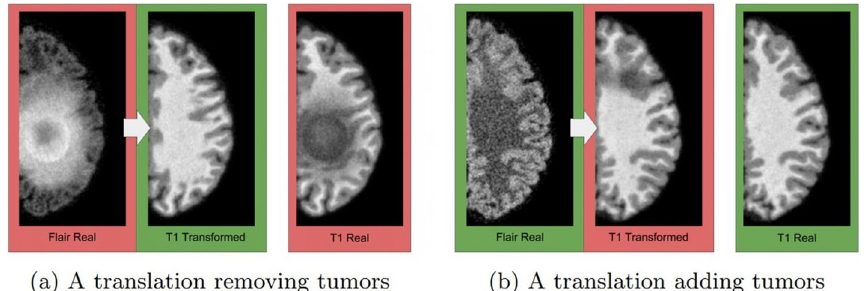
Fig. 19 An example of medical image translation